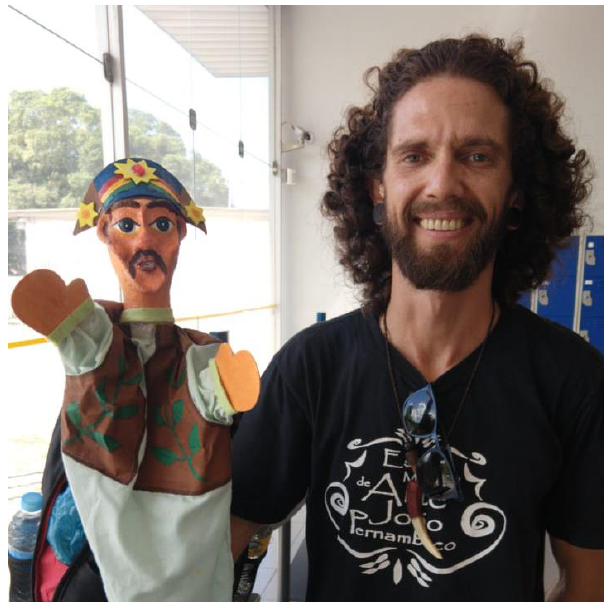
Figure 4. Justino Guerreiro paper-mache puppet by Fernando Alvim.